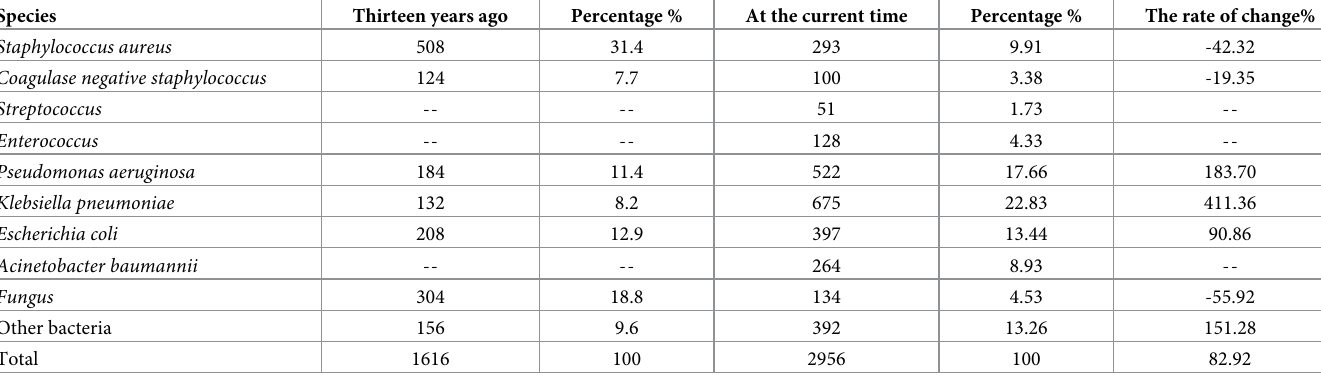
Table 2. The comparison of types and quantities of pathogenic bacteria before and after 13 years.